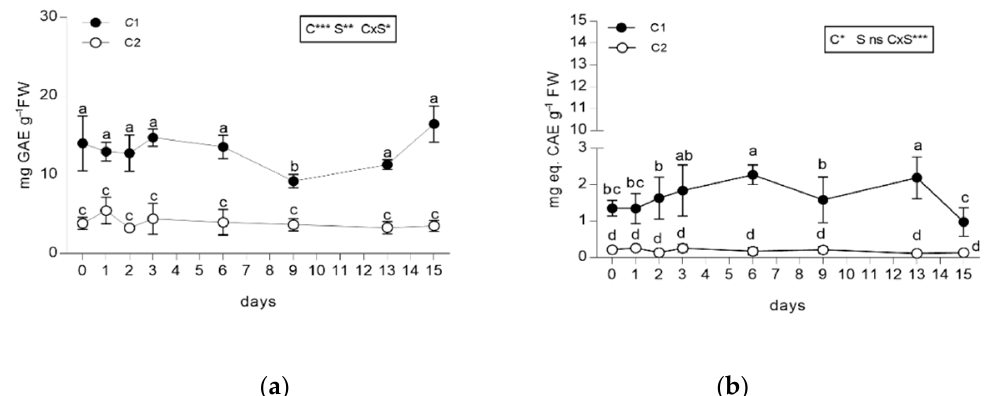
Figure 1. Total phenolic content ( a ) and flavonoid content ( b ) of Rumex acetosa stored at 4 °C for 15 days as fresh-cut products. Closed and open symbols represent first (C1) and second harvests (C2), respectively. Each value is the mean (±SD) of three replicates. Means having the same letter are not significantly different at p = 0.05 following two-way ANOVA with storage (S) and cut (C) as variables. F values for main effects and their interaction significant at p < 0.05 (*); p < 0.01 (**); p < 0.001 (***), or not significant (ns). Total phenol content values and flavonoid content values were expressed as gallic acid equivalents (GAE) mg g − 1 FW and as catechin equivalents (CAE) mg g − 1 FW,